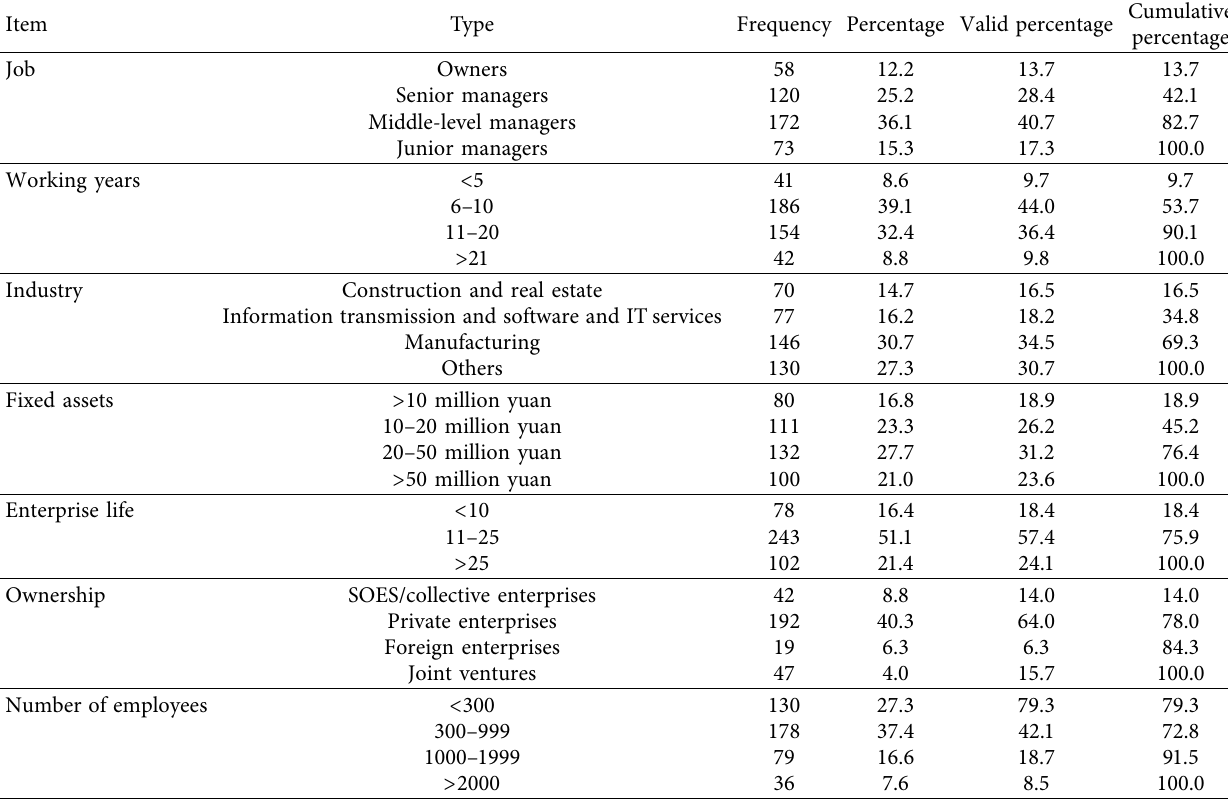
Table 2: Statistics of the basic information of the